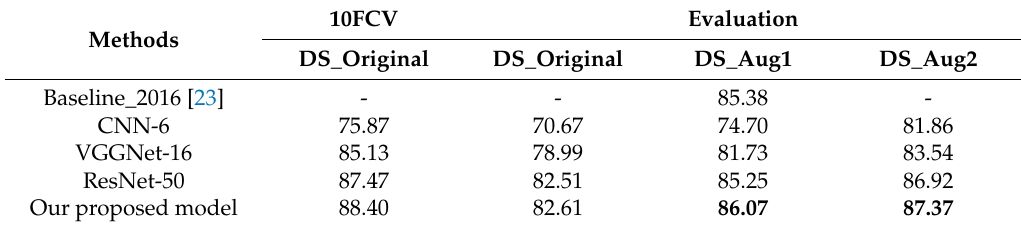
Table 2. Accuracy of visual methods in